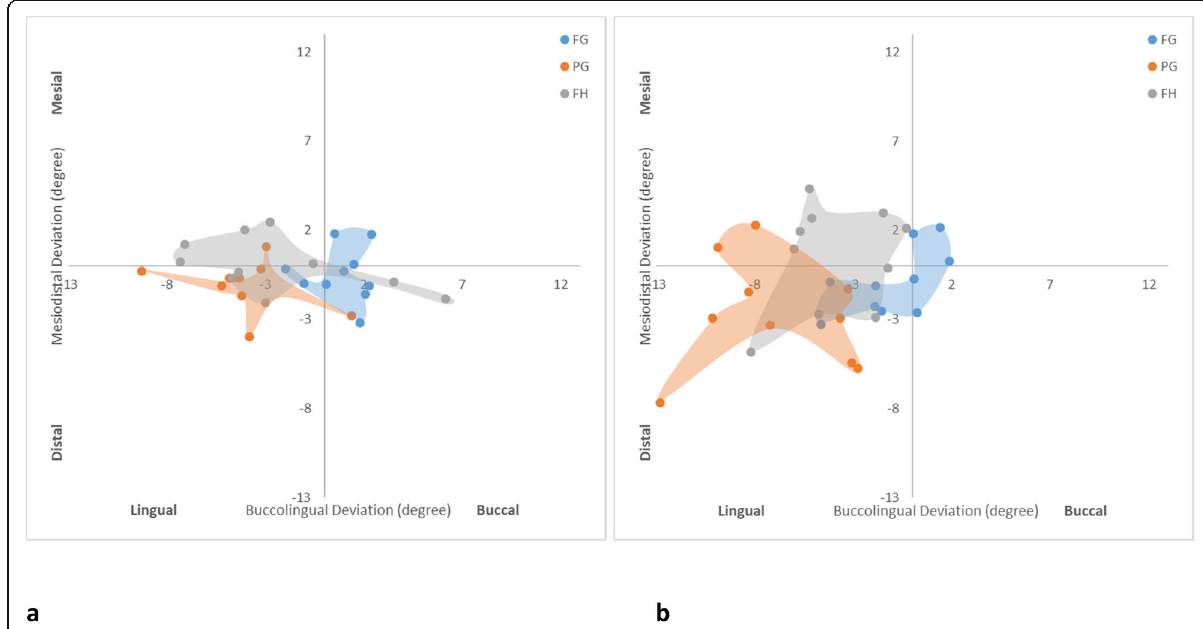
Fig. 9 Scatter diagrams illustrating the distribution of angle deviation of each protocol. a Anterior implants. b Posterior